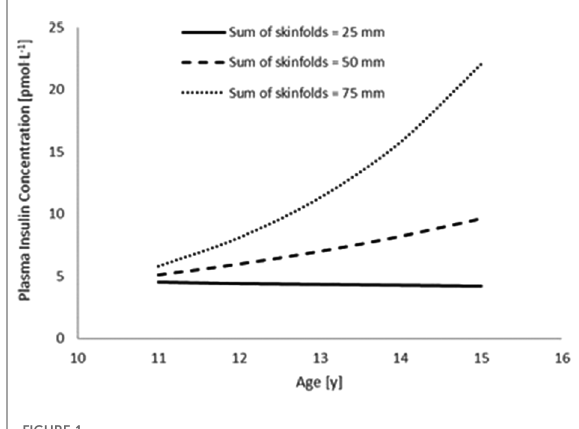
FIGURE 1 The interaction between sum of skinfolds and age, to affect plasma insulin concentration ( n =45). Modelled data display the mean sum of skinfolds (50 mm)±1 SD (25 mm and 75 mm) (age * sum of skinfolds interaction, p